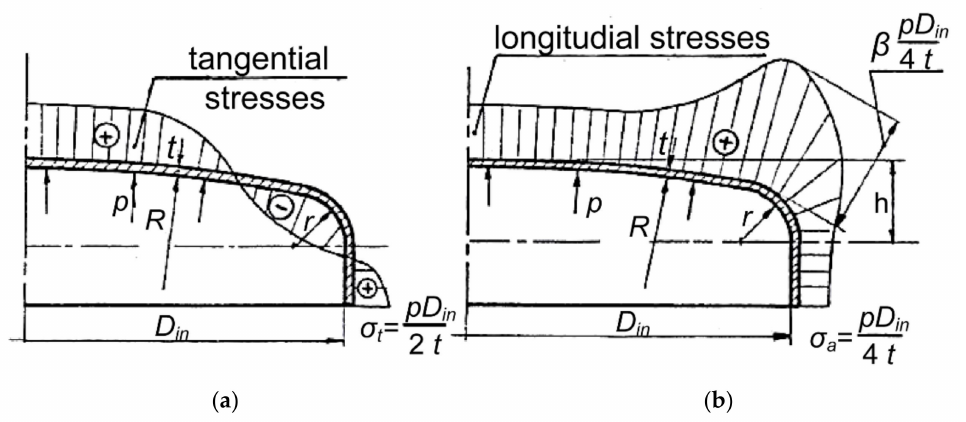
Figure 9. Stresses in the wall of the bottom due to the internal pressure in the vessel ( a ) tangential stresses ( b ) axial stresses